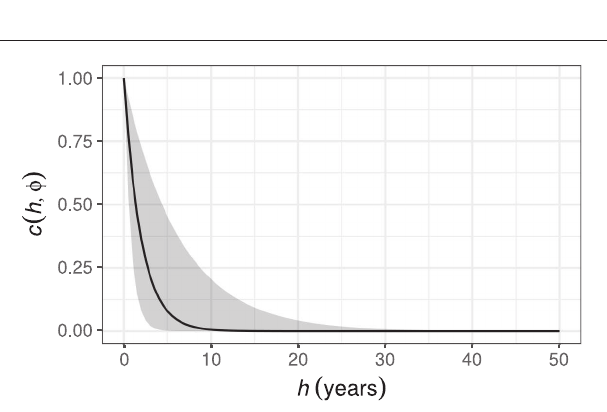
FIGURE 11 | Estimated CAR(1) process from the GAM fitted to the Small Water δ 15 N time series. c ( h , φ ) is the correlation between residuals separated by h years, where ˆ φ = 0.6. The shaded band is a 95% pointwise confidence interval on the estimated correlation c